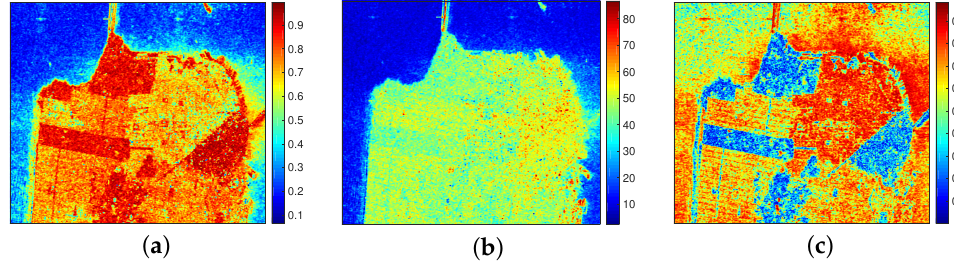
Figure 3. Cloude–Pottier decomposition results of the RadarSat-2 PolSAR image. ( a ) Entropy. ( b ) Alpha angle. ( c )